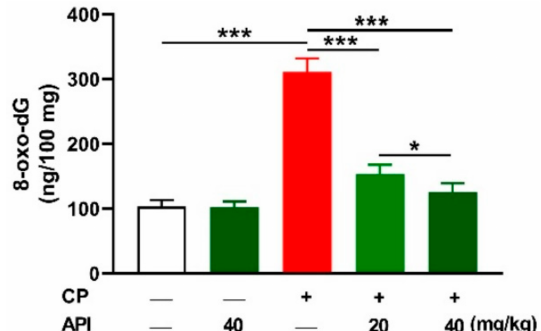
Figure 5. API ameliorated oxidative DNA damage in CP-intoxicated rats. Pre-treatment with API decreased hepatic 8-oxo-dG in a dose-dependent manner. Data are mean ± SEM, ( n = 6). * p < 0.05 and *** p <